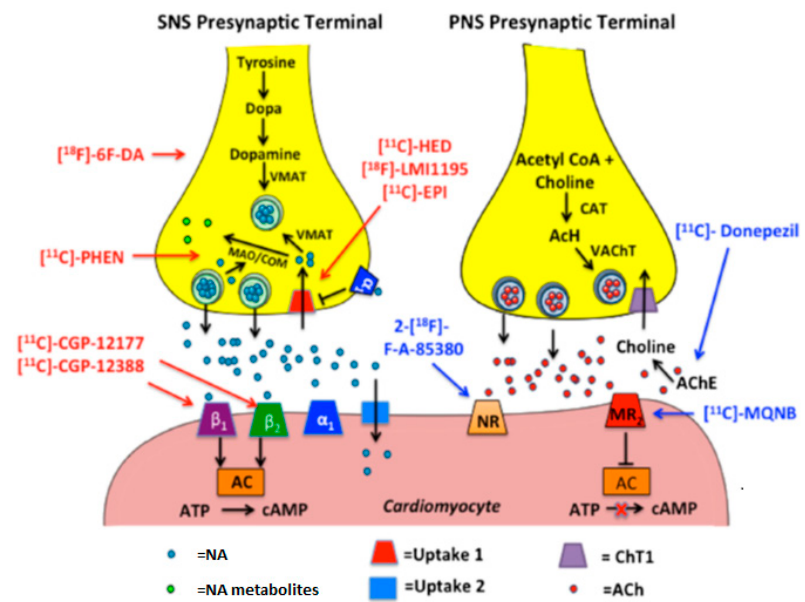
Figure 2. The illustration depicts postganglionic SNS and PNS nerve endings. The left panel displays the synthesis and release of noradrenaline in postganglionic SNS nerve endings and subsequent binding to postsynaptic receptors on cardiomyocytes. The tracers in red depict SNS pre- and post-synaptic radio analogs. The right panel shows the synthesis and release of acetylcholine in the terminal nerve ending and varicosities of postganglionic PNS nerve endings and subsequent binding to postsynaptic receptors on cardiomyocytes. Tracers in blue depict PNS pre- and post-synaptic radio analogs. AC = adenylyl cyclase, ACh = acetylcholine, AChE = acetylcholinesterase, ATP = adenosine